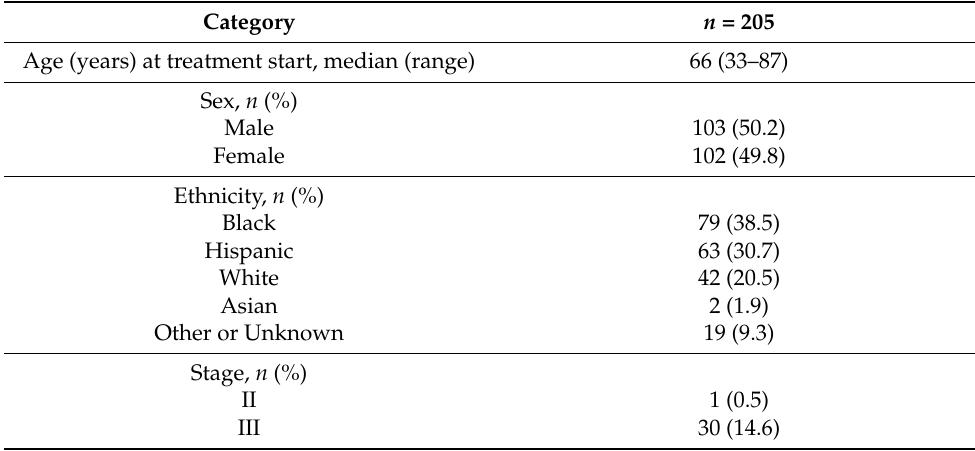
Table 1. Baseline